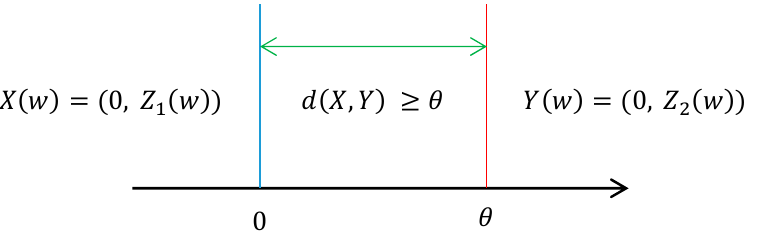
Figure 5. Example of two probability distributions.